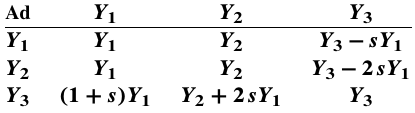
Table 4. Adjoint representation (MBBM